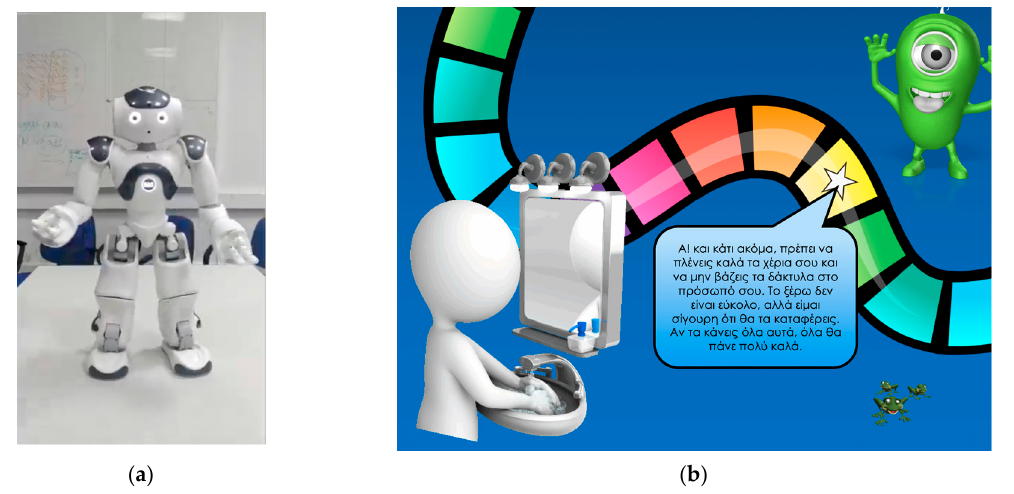
Figure 2. Screenshot of the robot-based video and a slide from the interactive presentation: ( a ) Screenshot of video; ( b ) Example presentation slide.